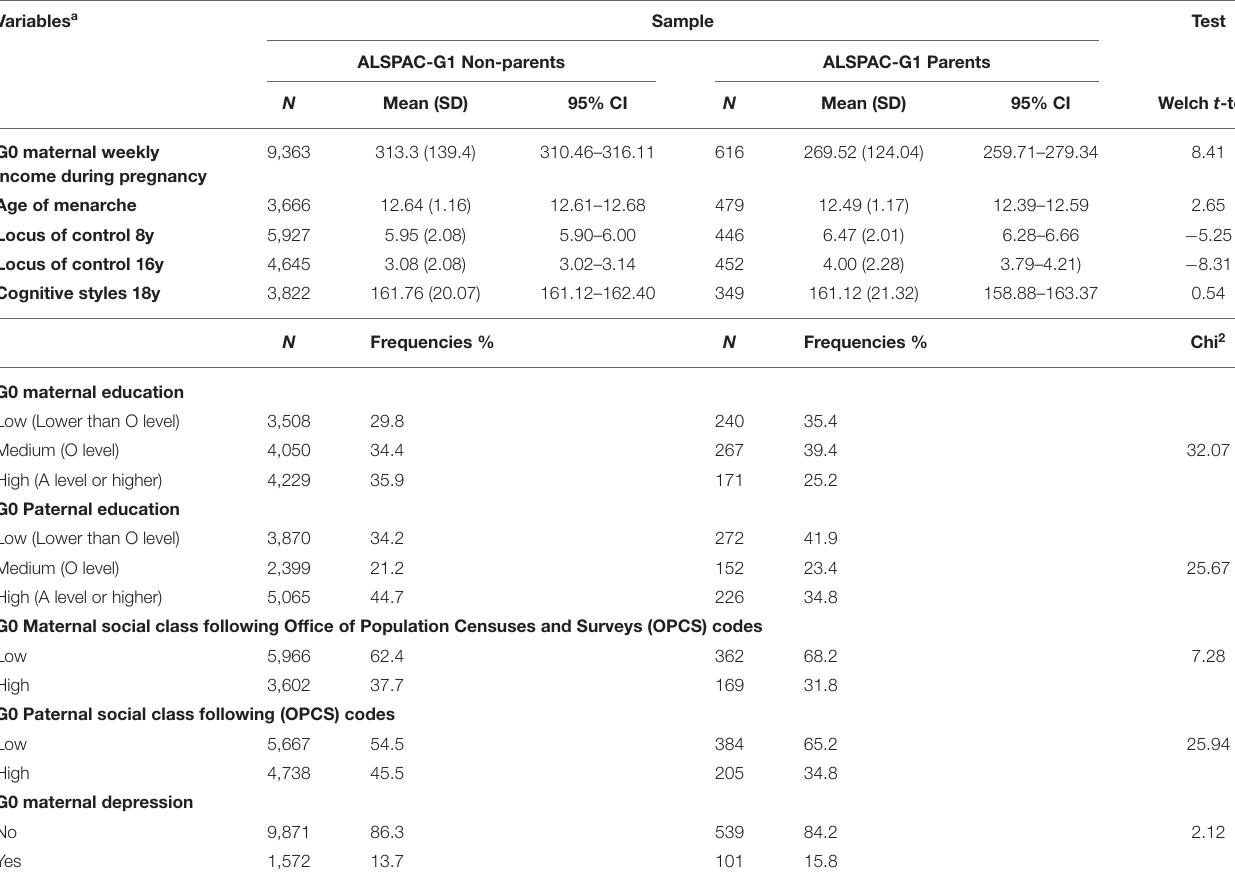
TABLE 1 | Demographic and psychological differences between ALPSAC-G1 parents (either those who enrolled and those who did not enroll in ALSPAC-G2) and non-parents. Variables